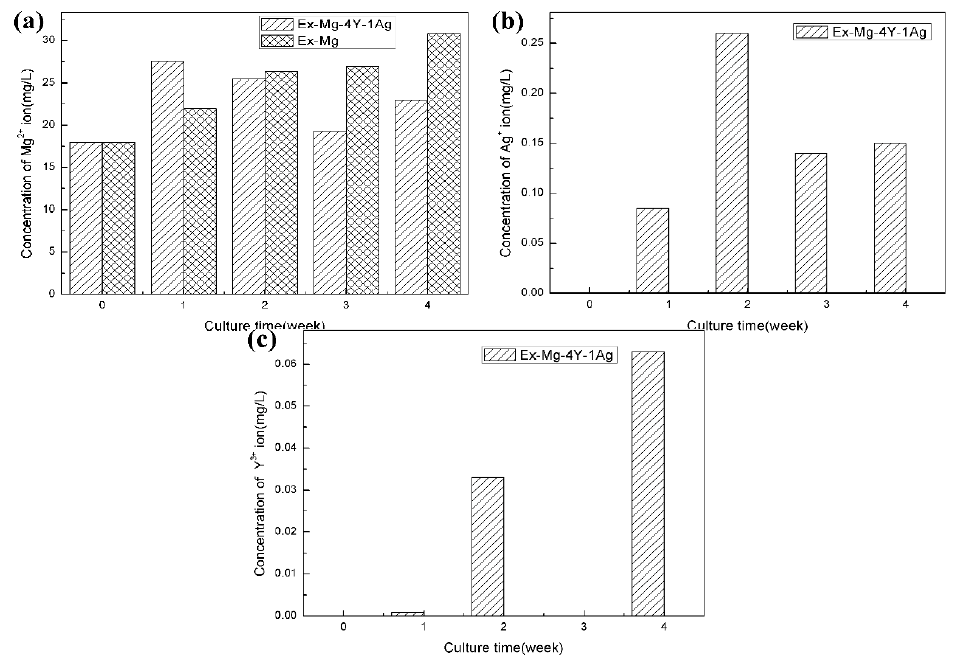
Figure 8. Mg 2+ , Ag + , Y 3+ ion concentration variation of culture medium with Ex ‐ Mg ‐ 4Y ‐ 1Ag and Ex ‐ Mg: ( a ) Mg 2+ ; ( b ) Ag + ; ( c ) Y 3+ .